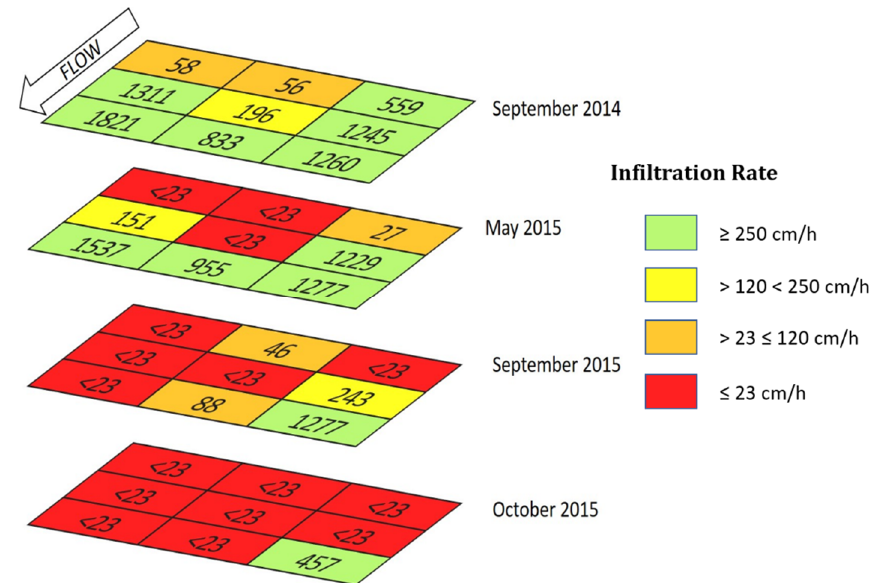
Figure 4. Heat map illustrating the progression of clogging across the permeable interlocking pavers surface over the first 14 months of the study when no restorative maintenance occurred. Adapted from Selbig and Buer [1] (cm/h, centimeters per hour).